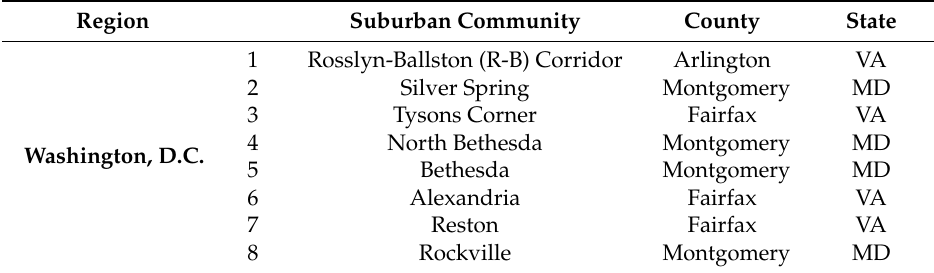
Table 1. The examined suburbs in the Washington, D.C. Metropolitan